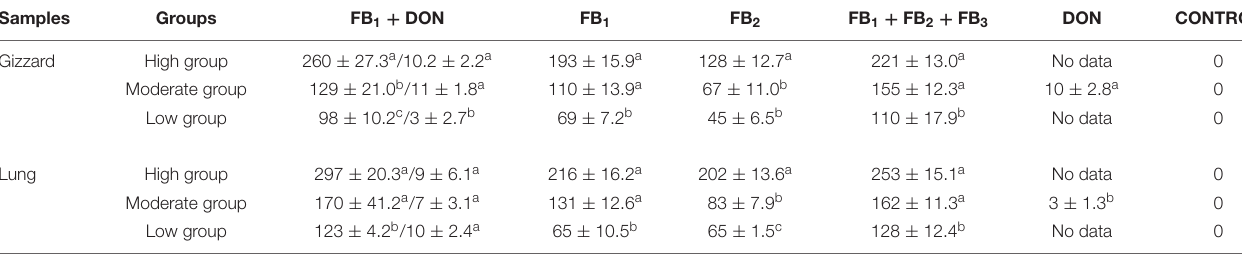
TABLE 4 | Residue of FB/DON in the gizzard and lungs of newborn chickens ( µ g/kg). Samples